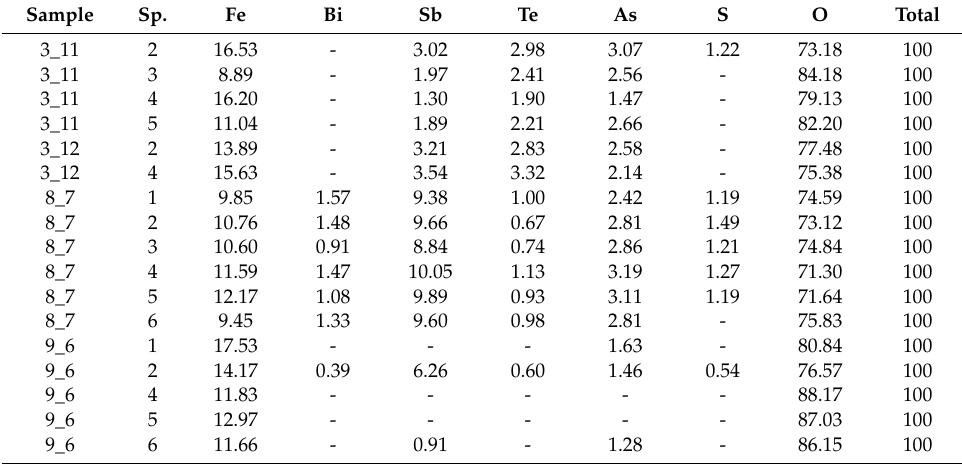
Table 4. Compositions (at. %) of oxides / hydroxides of Fe, Sb, Te, As, Bi, and S (after removal of Au and Ag) localized in the pores of mustard gold (data of Table 3 recalculated to 100%). Sample